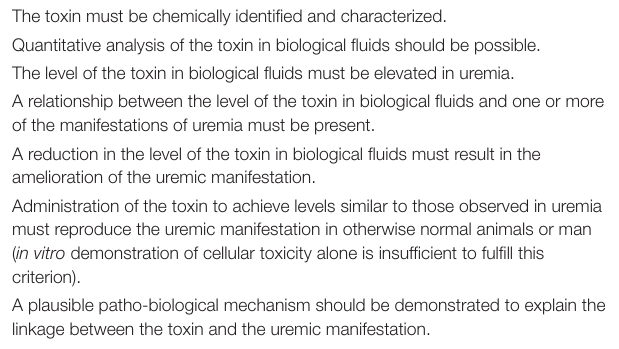
TABLE 1 | Requirements for compounds to be considered uremic toxins ( adapted from Glassock, 2008). The toxin must be chemically identified and